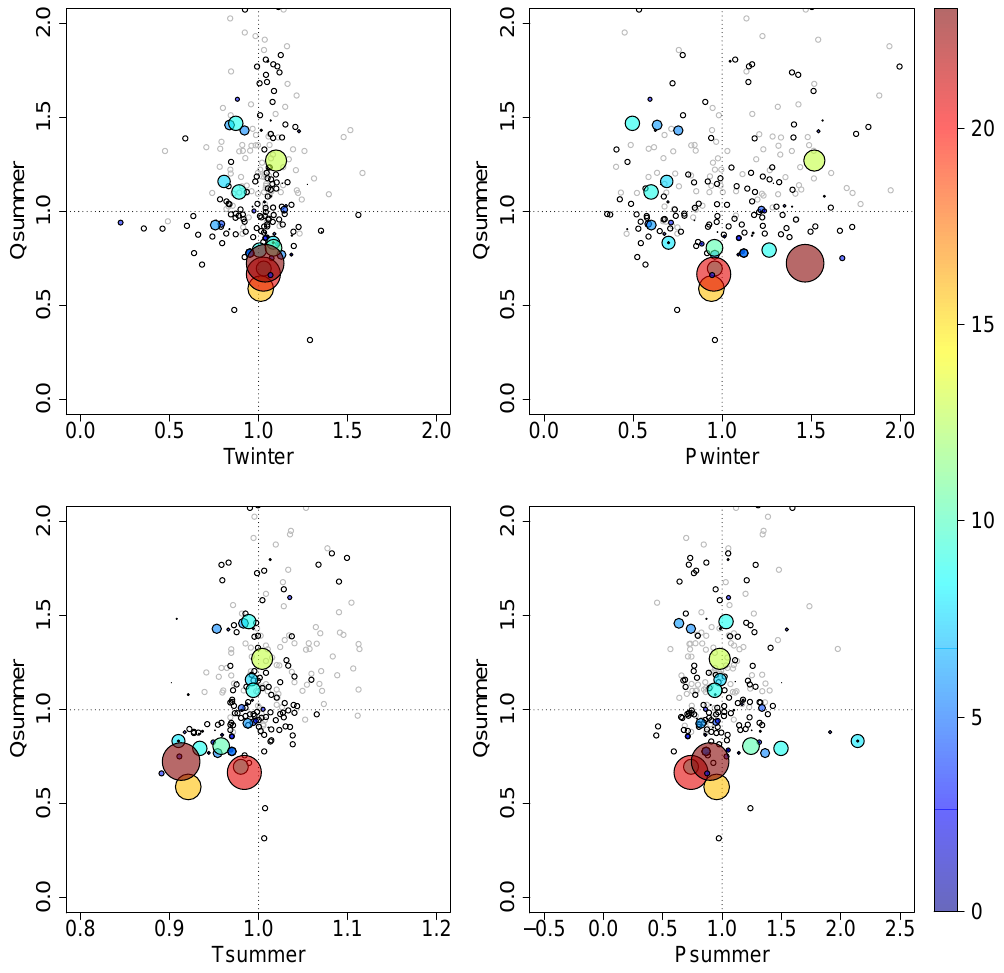
Figure 7. Glaciermelt drought events in Norwegian catchments: standardised summer discharge ( Q summer ) (–) against standardised causing factors ( T winter , P winter , T summer , P summer ) (–). Below 1 = below average; above 1 = above average. Grey circles: all years; black circles: all drought years; coloured circles: glaciermelt drought years (size and colour of dots are dependent on standardised drought deficit (–); scale on the right side of the figure).